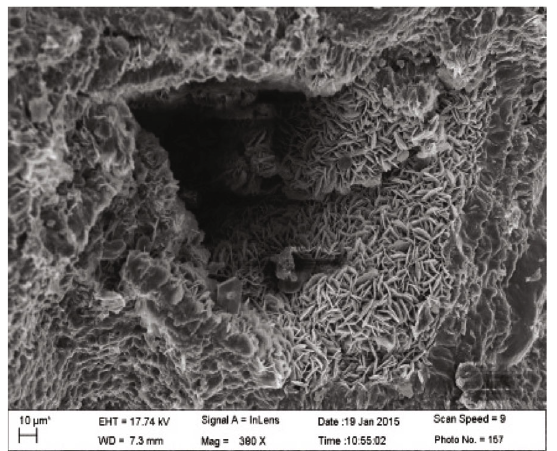
Figure 7: Pore lining primary pores surrounded by chlorite, well B202, 3096.25m,